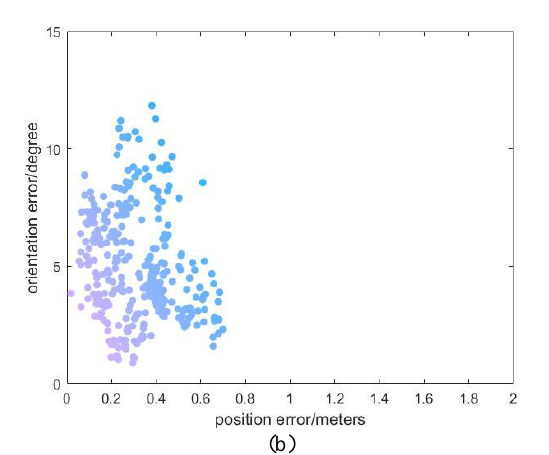
Figure 6 . Scatter plot of errors. (a–b) correspond to position error and orientation error. Figure 7 as the cumulative error histogram of the CoRBS test set shows the positioning performance of the two methods from a more quantitative and intuitive perspective. Figure 7a shows the position error, and Figure 7b shows the orientation